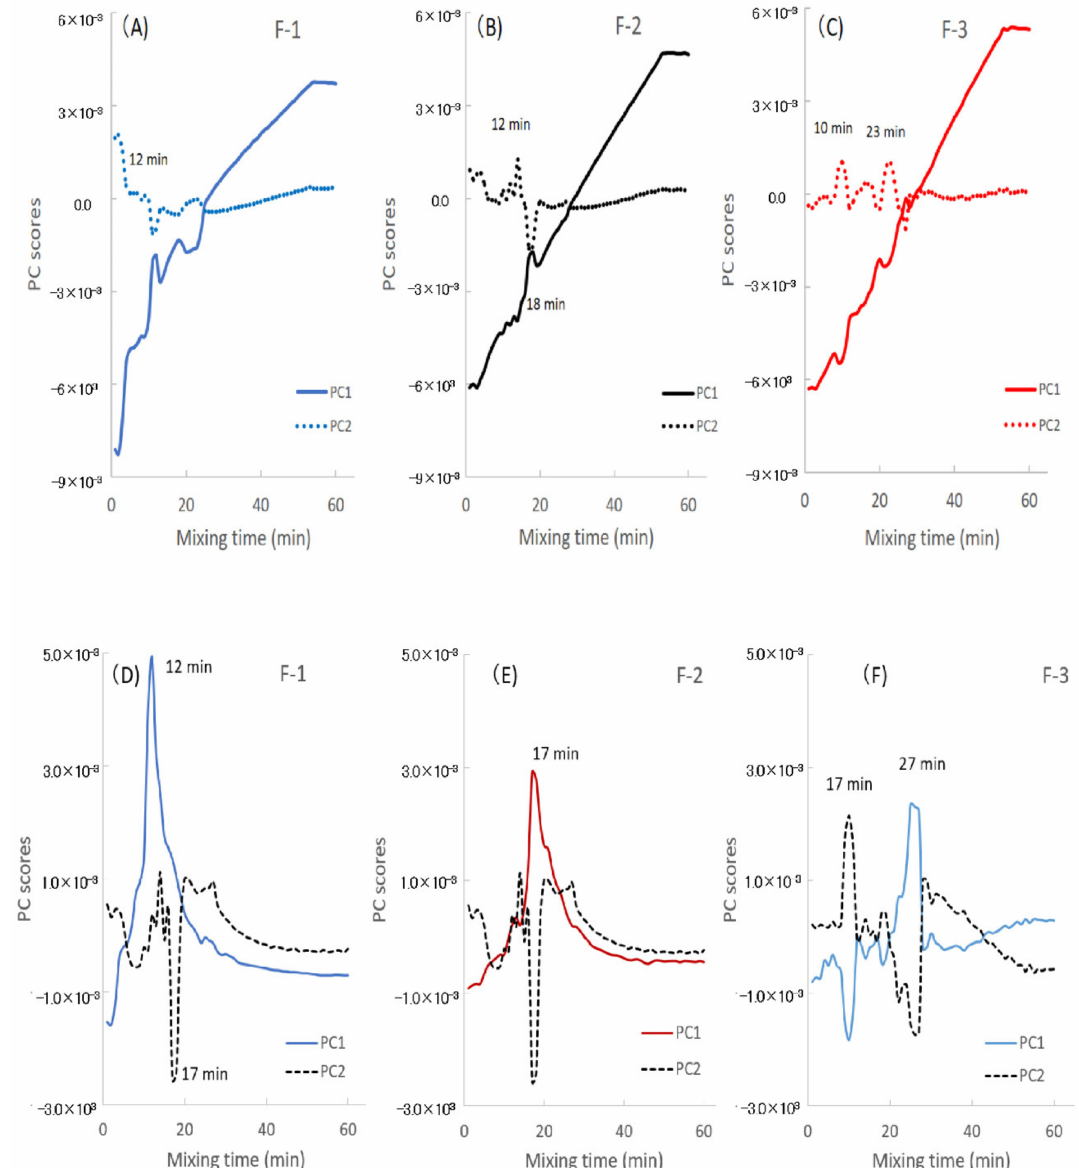
Figure 6. ( A – C ) Score–time profiles of the partial least-squares regression calibration models for the amount of water added and the agitation power consumption during high-speed shear wet granulation processes of all formulations. ( A – C ), the amount of water for lactose, mixture, and starch samples. The solid line is LV1, the dot line is LV2. ( D – F ) Score–time profiles of the partial least-squares regression calibration models for the amount of water added and the agitation power consumption during high-speed shear wet granulation processes of all formulations. ( D – F ), the agnation power consumption for lactose, mixture, and starch samples. The solid line is LV1, the dot line is